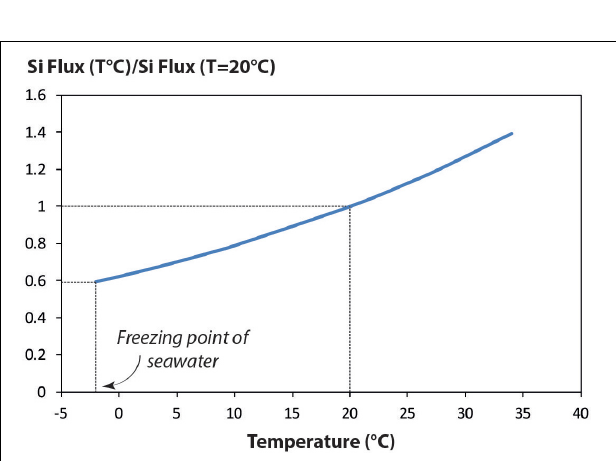
FIGURE 6 | Si flux ratio between value for T = 20 ◦ C and a range of temperatures comprised between –2 and +34 ◦